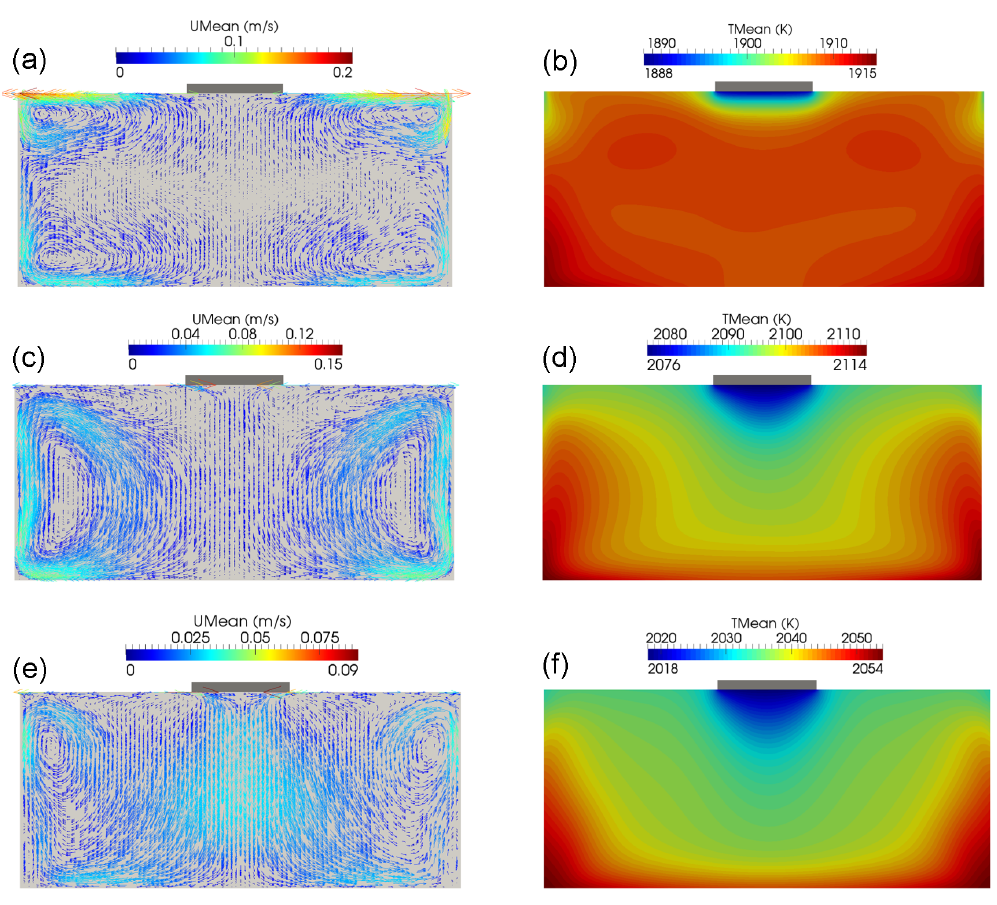
Figure 5. Time-averaged flow velocity vectors and temperature distribution in the vertical plane ( y = 0) for ( a , b ) Case 1, ( c , d ) Case 2, and ( e , f ) Case